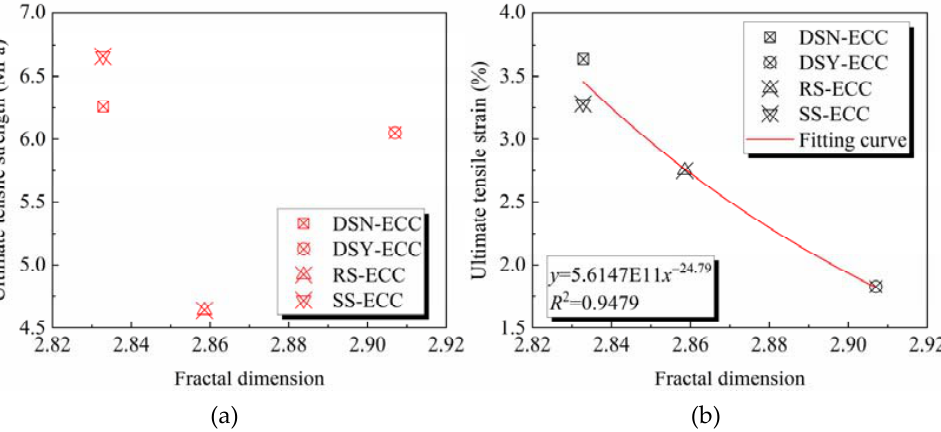
Figure 12. Relationship between fractal dimension and ( a ) ultimate tensile strength; ( b ) ultimate tensile strain.